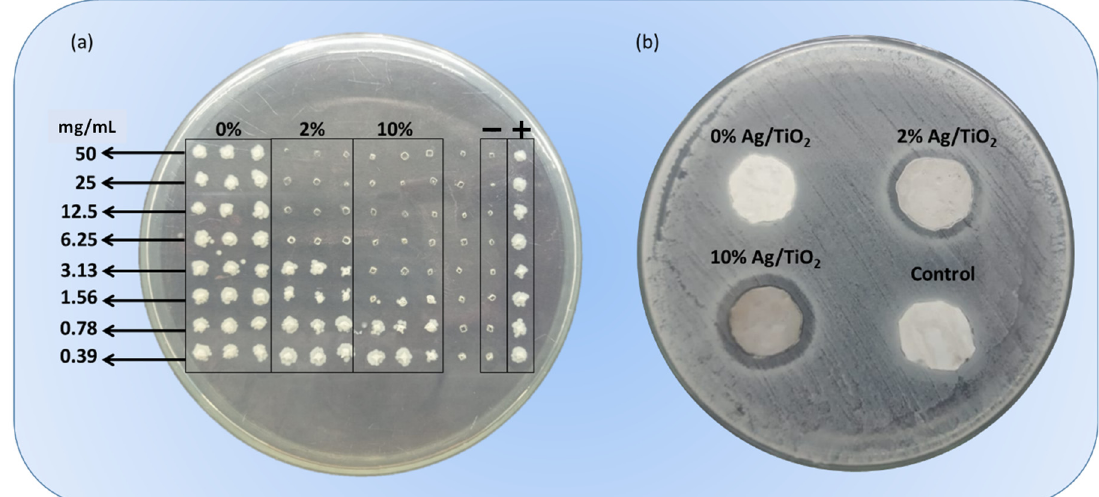
Figure 4. ( a ) MBC assays for di ff erent compounds at a progressive reduction in the concentrations against S. aureus . From left to right: positive control, negative control, 10% Ag/TiO 2 , 2% Ag/TiO 2 , and 0% Ag/TiO 2 . ( b ) Inhibition zones for tilapia skin impregnated with mixed oxides: negative control, 10% Ag/TiO 2 , 2% Ag/TiO 2 , and 0% Ag/TiO 2 .